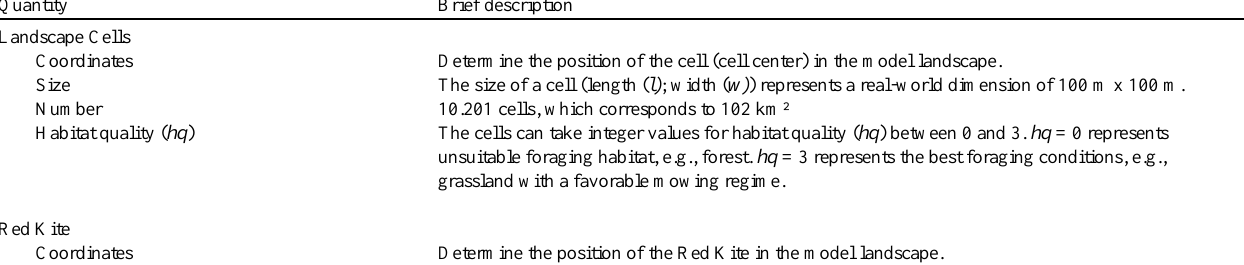
Table 1. Quantities included in the model and their description. Table rows are grouped according to the entities of the model. Quantity Brief description Landscape Cells Coordinates Determine the position of the cell (cell center) in the model landscape. Size The size of a cell (length ( l) ; width ( w) ) represents a real-world dimension of 100 m x 100 m. Number 10.201 cells, which corresponds to 102 km² Habitat quality ( hq ) The cells can take integer values for habitat quality ( hq ) between 0 and 3. hq = 0 represents unsuitable foraging habitat, e.g., forest. hq = 3 represents the best foraging conditions, e.g., grassland with a favorable mowing